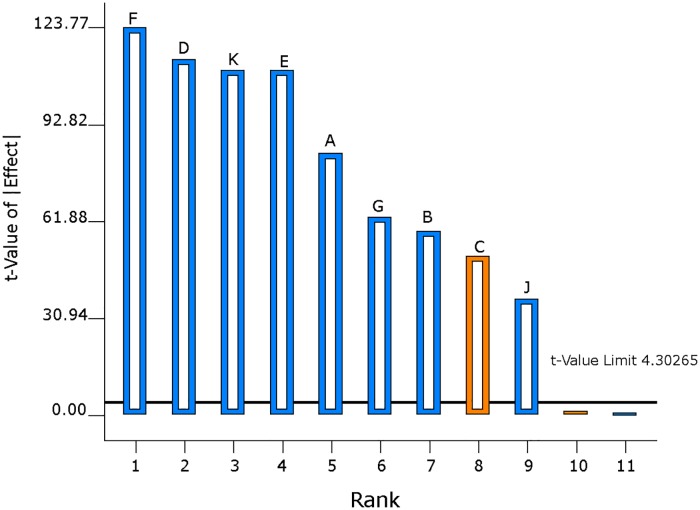
Graph of t-value of absolute effects verses rank.This is an ordered bar chart, which shows the magnitude of the chosen parameters for the model. The bars above the t-value (the reference line) with white represent the significant effects and the bars below the reference line are insignificant. Data generated for L12 OA design parameters: vortexing duration (F), concentration of PVA in emulsion (D), solvent evaporation duration (K), vortexing speed (E), concentration of PLGA (A), organic/aqueous phase ratio(G), solvent type (B), molecular weight of PVA (C) and stirring speed for hardening process (J).